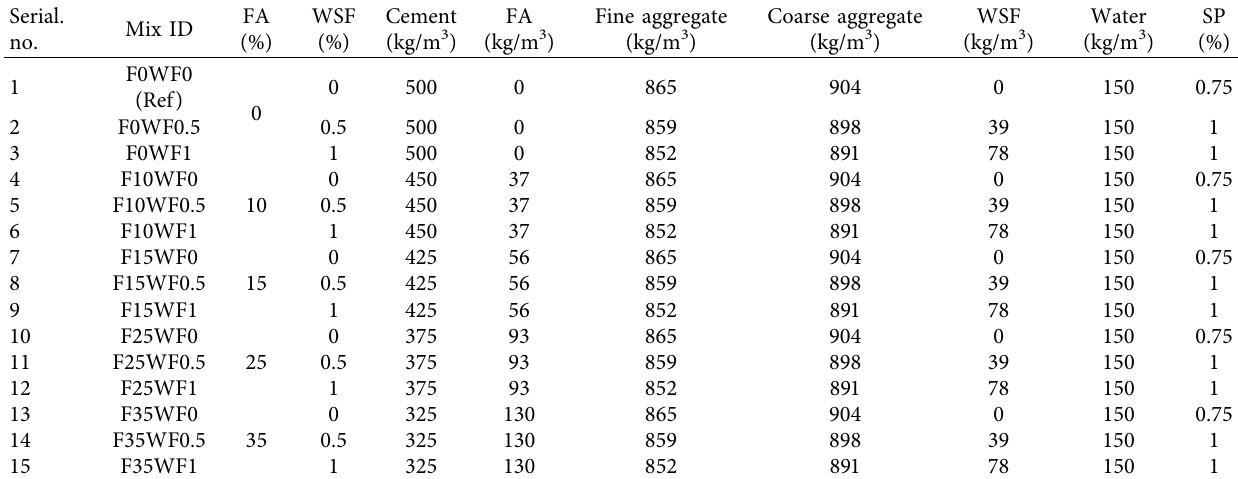
Table 3: Information about the composition of concrete